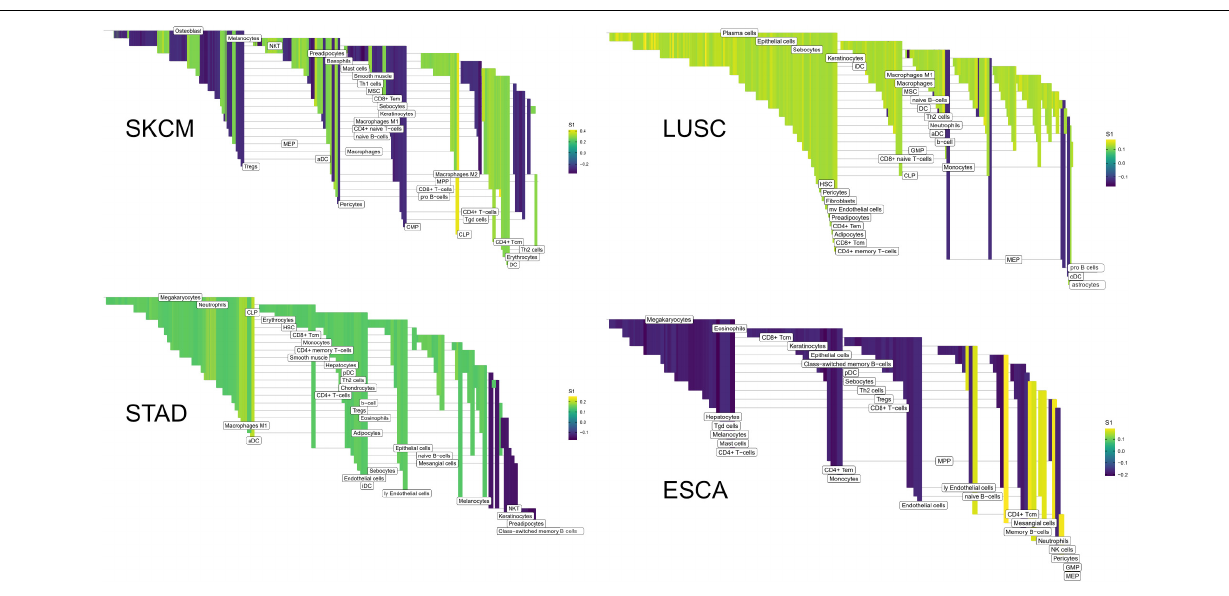
Frontiers in Genetics |